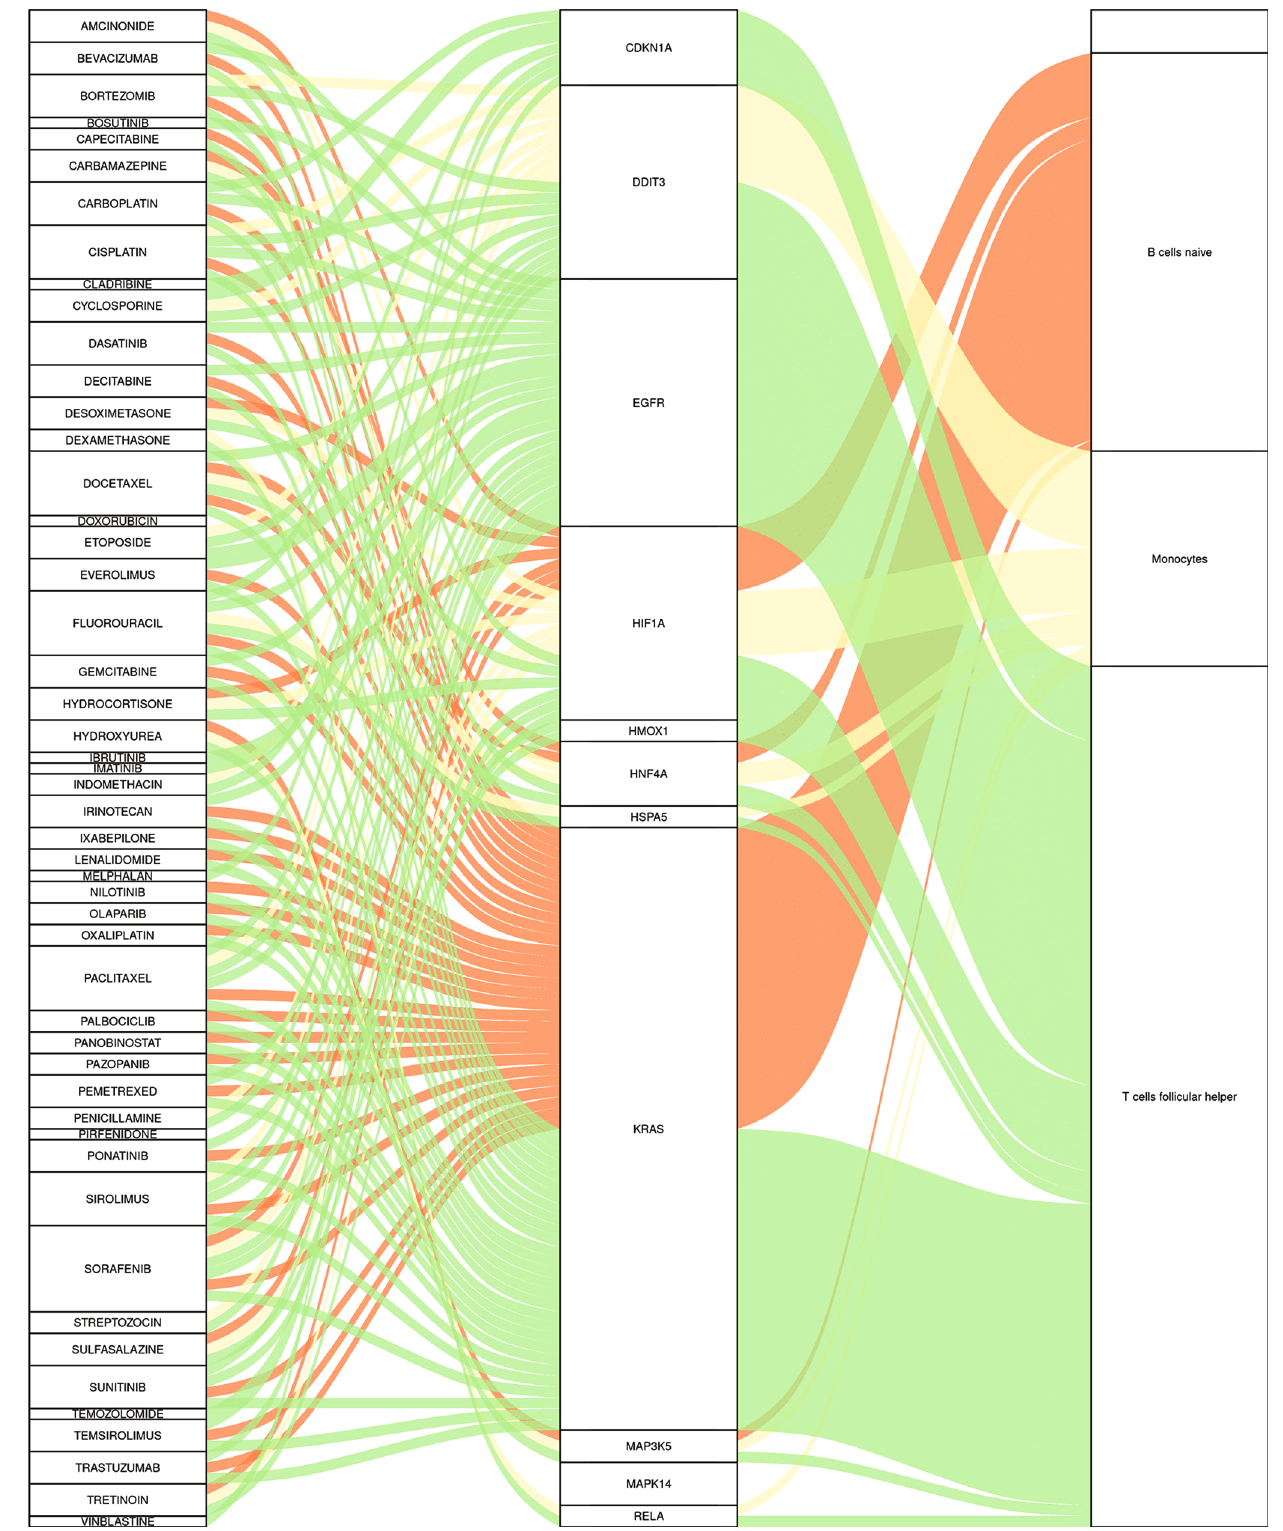
Figure 5: The Sankey diagram between potential therapeutic agents, genes, and immune